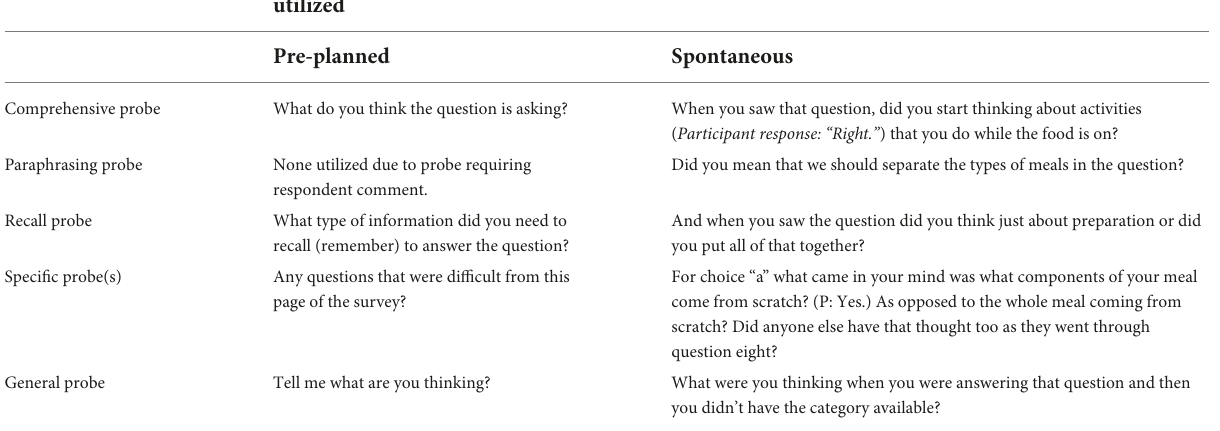
TABLE 1 Examples of verbal probes utilized during the cognitive interview focus group during pretesting of the cooking behavior